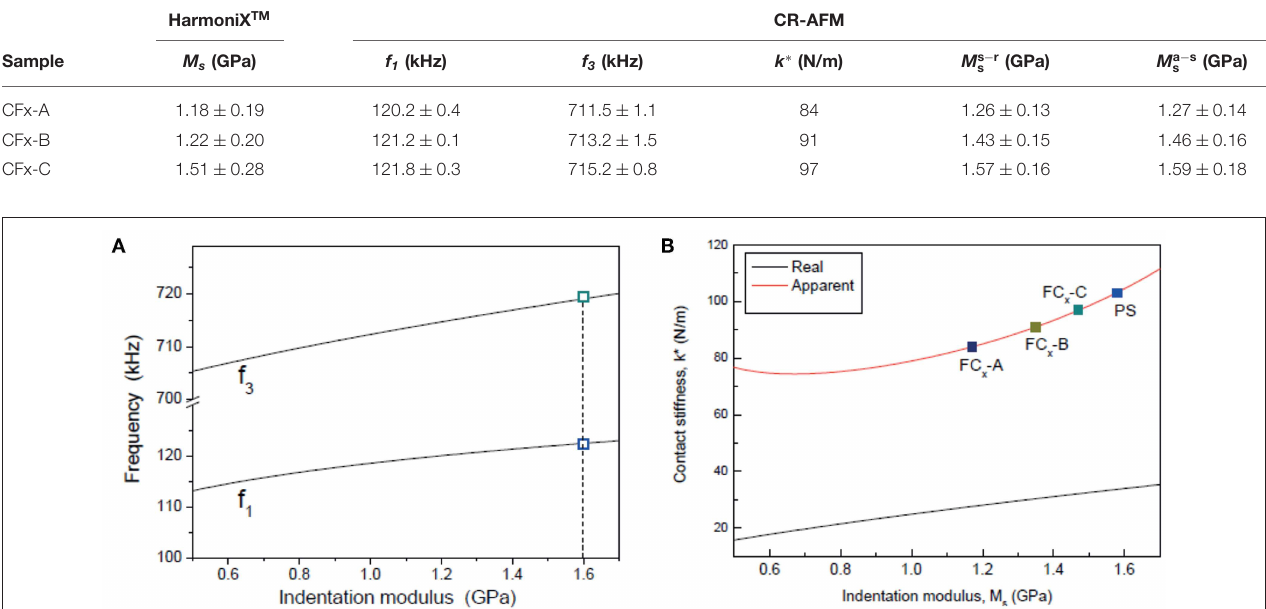
TABLE 1 | Result of the nanomechanical characterizations using HarmoniX TM and CR-AFM: indentation modulus obtained with HarmoniX TM ( M s ); first and third flexural CRFs ( f 1 and f 3 , respectively); calculated contact stiffness k ∗ ; indentation modulus calculated using the “single reference” method and the “apparent stiffness” method ( M s-r s and M a-s s , respectively).